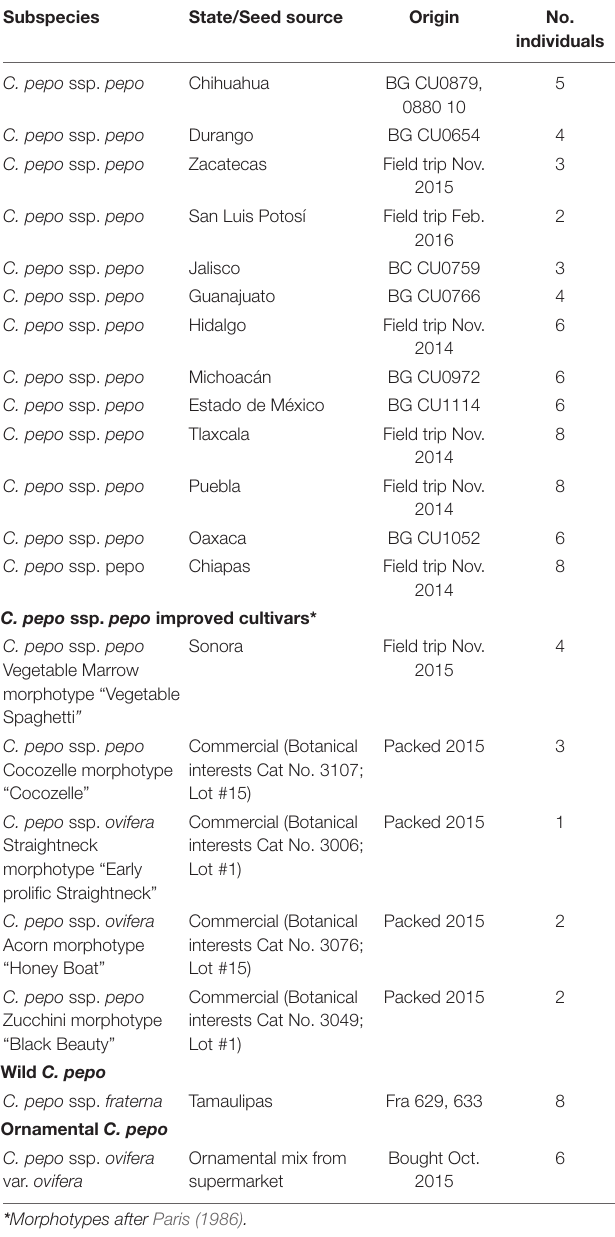
TABLE 1 | Sampling information for each subspecies with State, Origin (germplasm collection or field trip), and number of individuals grown for each